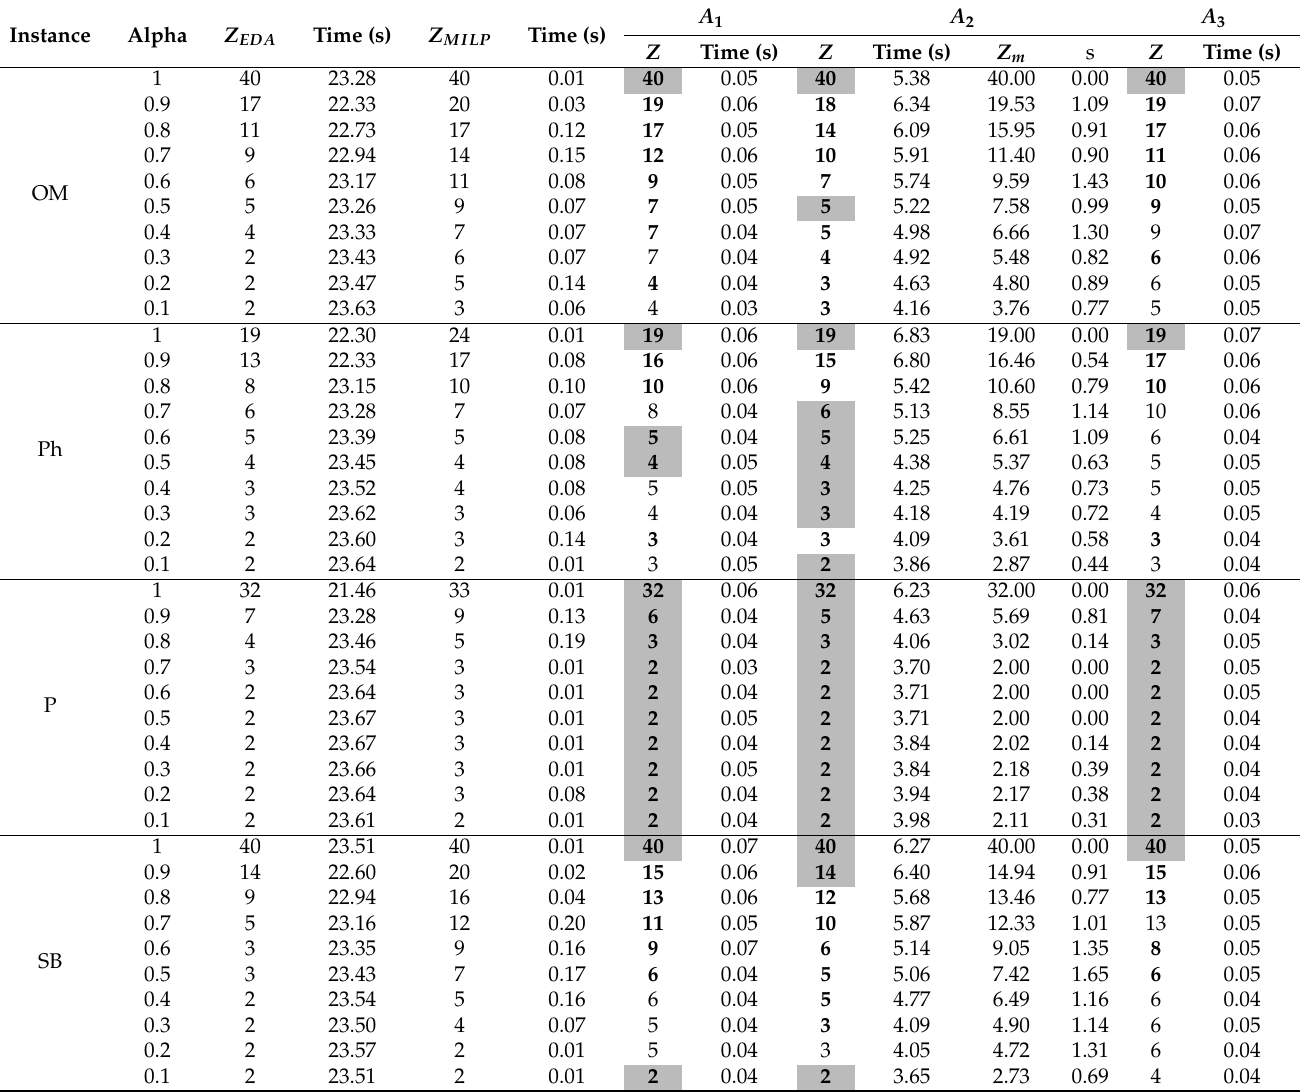
Table 2. Results of real data